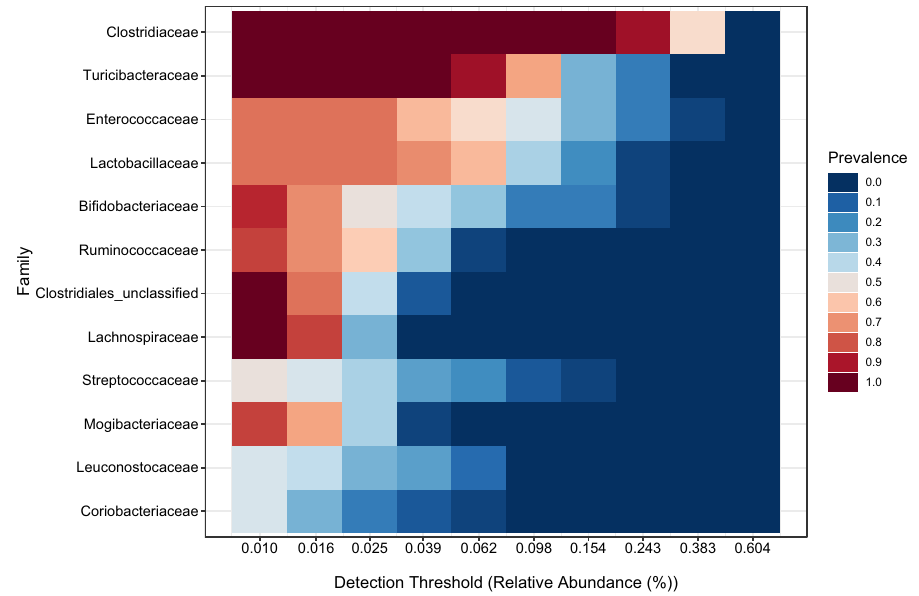
Figure 3. Core microbiome at the family level of feedlot cattle fecal samples displayed by a heatmap generated by pipeline Microbiome Analyst (http:// micro biome analy st. ca/ faces/ home. xhtml). Color shading indicates the prevalence of each bacterial family among samples for each abundance threshold. As we increased the detection threshold, the prevalence decreased.